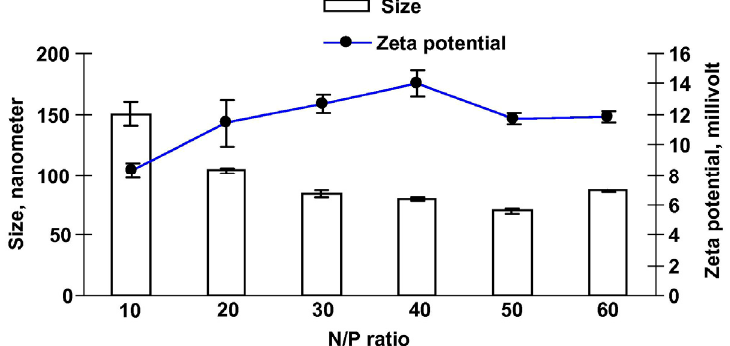
Figure 2. Effect of N/P ratio on the size of oligochitosan/pDNA polyplexes suspended in HEPES medium 10 mM, pH 7.1. Reproduced from [33] with permission from